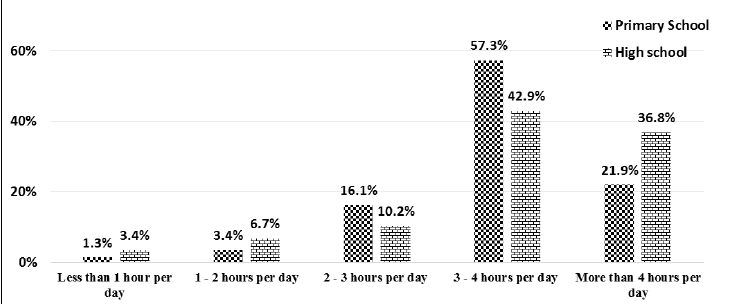
Figure 2. Distribution of children’s social media use among primary and high school students.